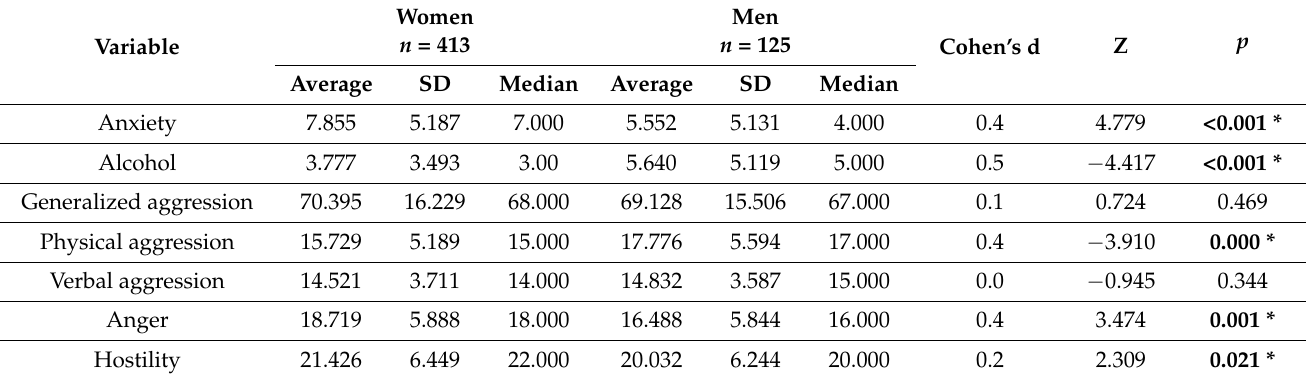
Table 6. Sex differences in terms of the studied